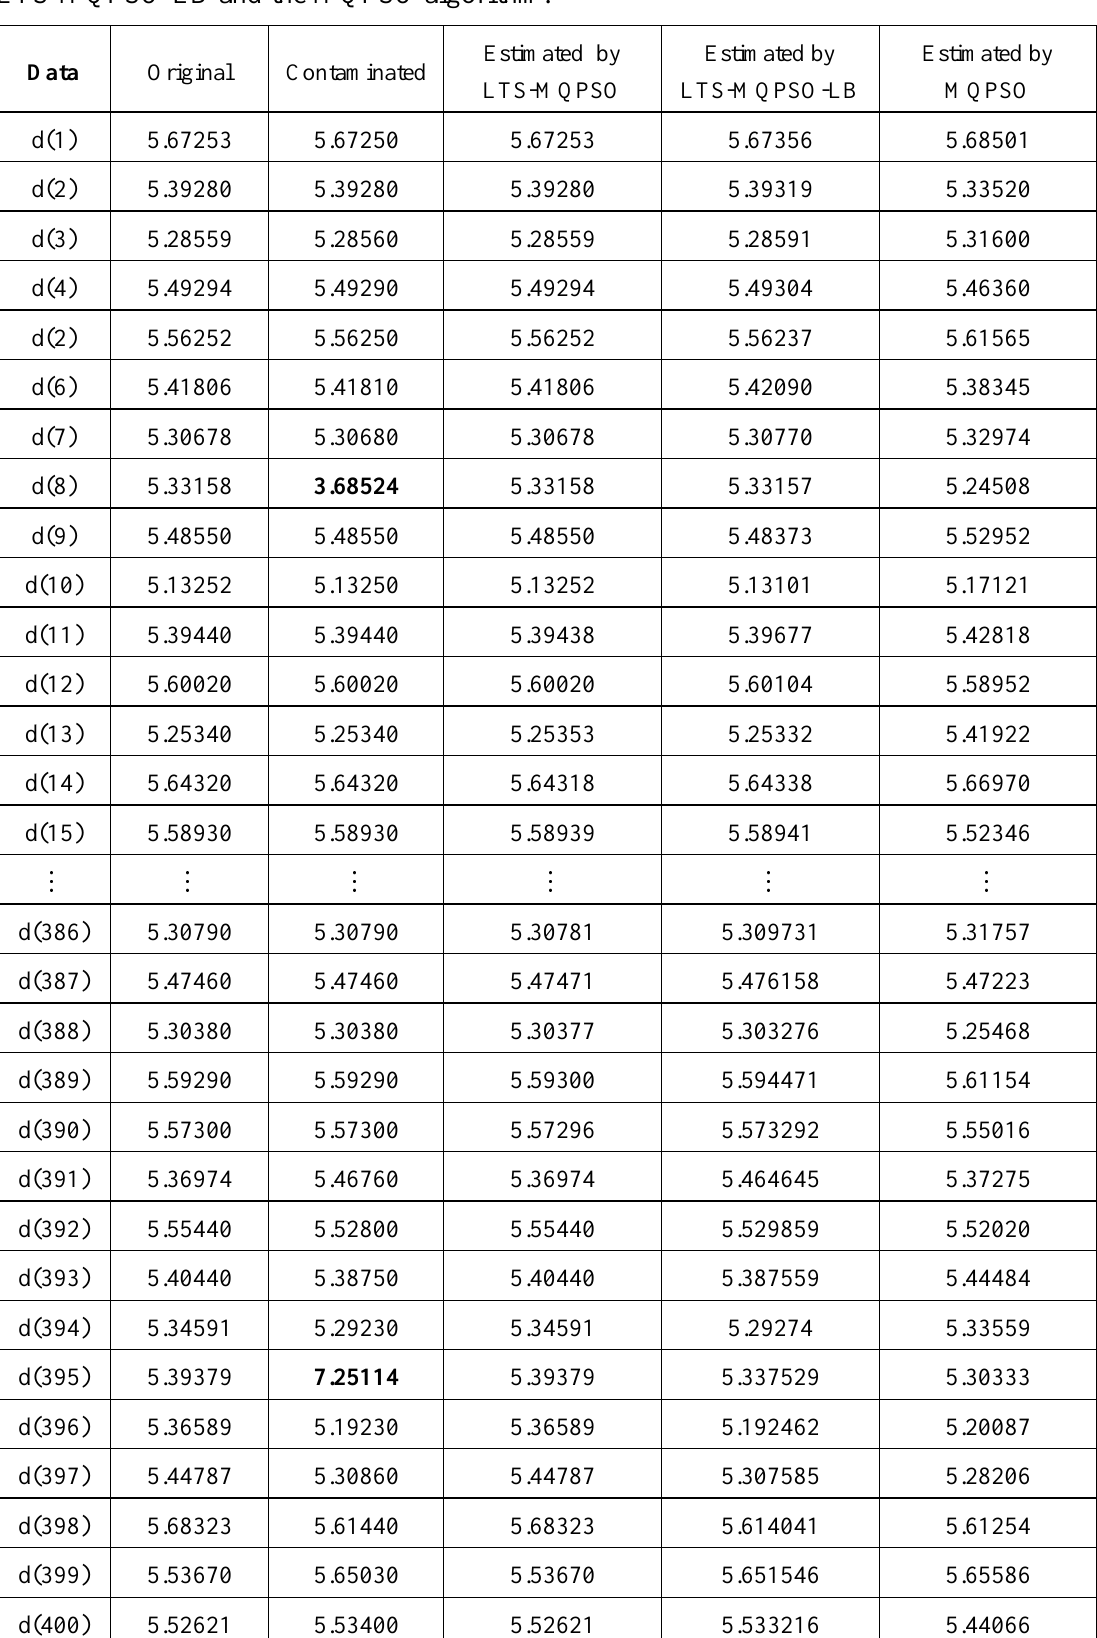
Table 3. The average results of objective attributes estimated by the LTS-MQPSO, the LTS-MQPSO-LB and the MQPSO